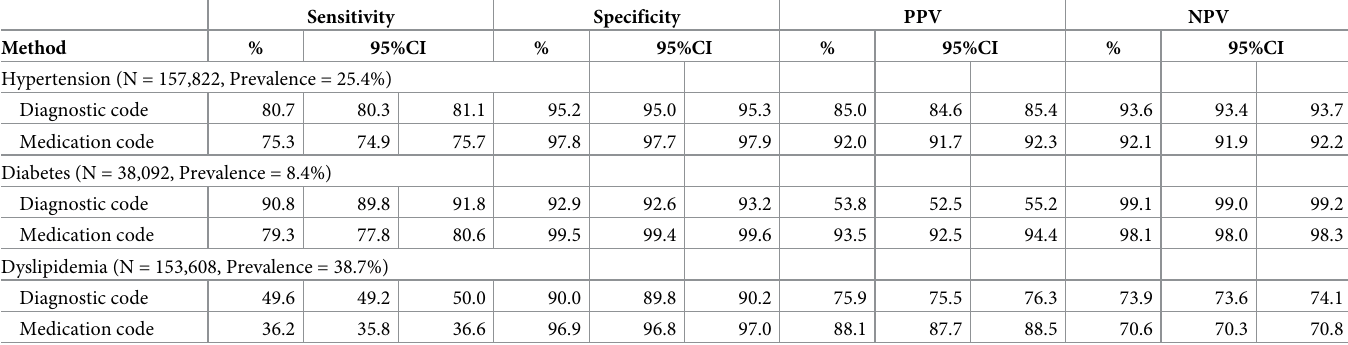
Table 4. Association measures and their 95% confidence intervals for the diagnostic code- and medication code-based claims-based algorithms. Sensitivity